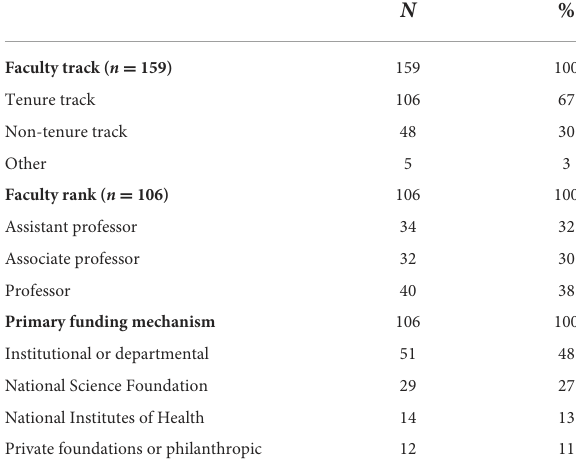
TABLE 3 Faculty roles, rank, and primary funding source.